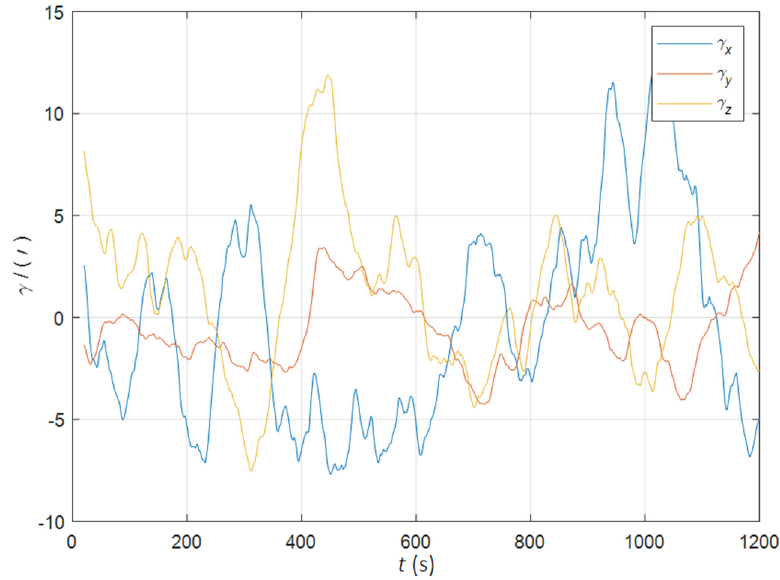
Figure 9. The curves of the dynamic deflection angle in the dynamic swing base. In the case of large and small initial misalignment angles, the error curves of φ are shown in Figures 10 and 11.